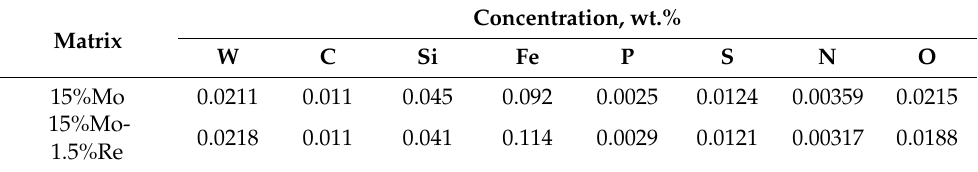
Table 7. The content of impurities in the NiAl–Cr–Co+15%Mo and NiAl–Cr–Co+15%Mo+1.5%Re alloys.